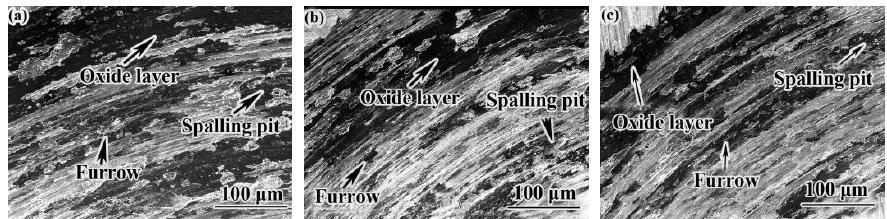
11 of 14 Figure 11. Weight and coefficient of friction at high-temperature: ( a ) the weight lost by friction; ( b ) friction coefficients. Figure 12 shows the high-temperature friction and wear morphology of samples in different states. The wear morphology of the samples in the three states is similar. Clear furrows, spalling pits and oxide layers can be seen in the wear topography. It shows that there was mainly abrasive wear, adhesive wear and oxidation wear between wheel and rail materials. When the surface of the specimens was subjected to stress, plastic defor- mation occurred. When the contact stress exceeded the limit, fatigue cracks appeared on the surface of the specimen. Under the continuous action of load, cracks propagated grad- ually, and spalling pits formed on the surface of the material under the action of shear stress [32]. EBSD analysis shows that the grain size became smaller after heat treatment. The large-angle grain boundaries between grains increased, and the large-angle grain